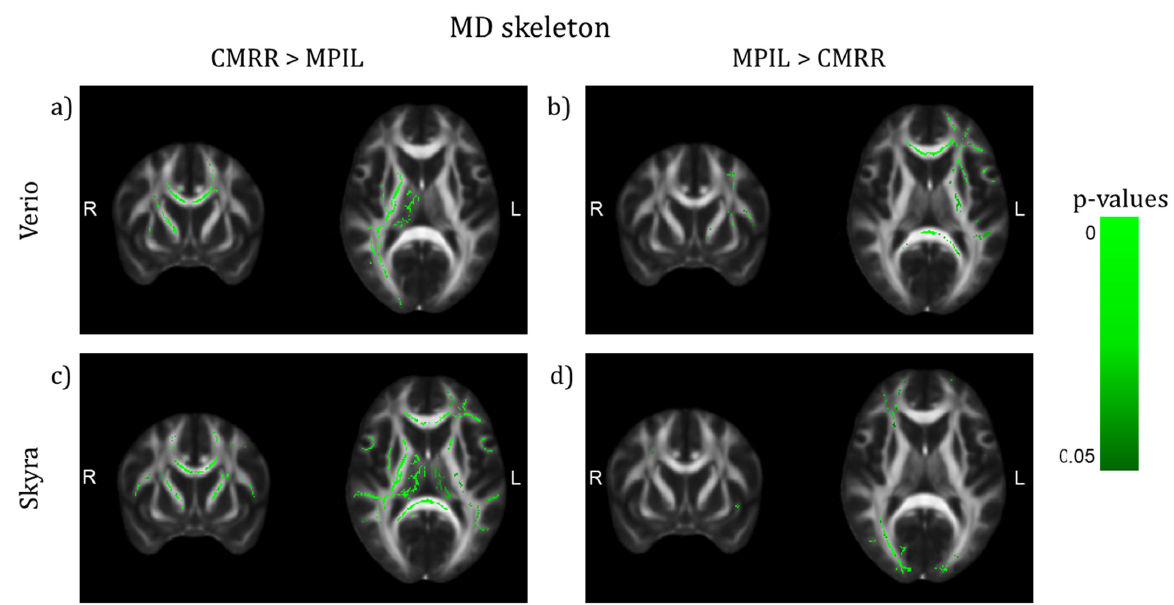
Figure 7. TBSS of differences on the MD skeleton between sequences after preprocessing with denoising (TFCE corrected, highlighted tracts: p < 0.05, (y,z) = (9,10)). ( a , c ) The CMRR sequence seems to deliver higher MD values in both hemispheres in central and lateral brain regions whereas the MPIL sequence shows higher MD values ( b ) in central and frontal regions and in the left hemisphere at Verio but ( d ) more occipitally and in the right hemisphere at